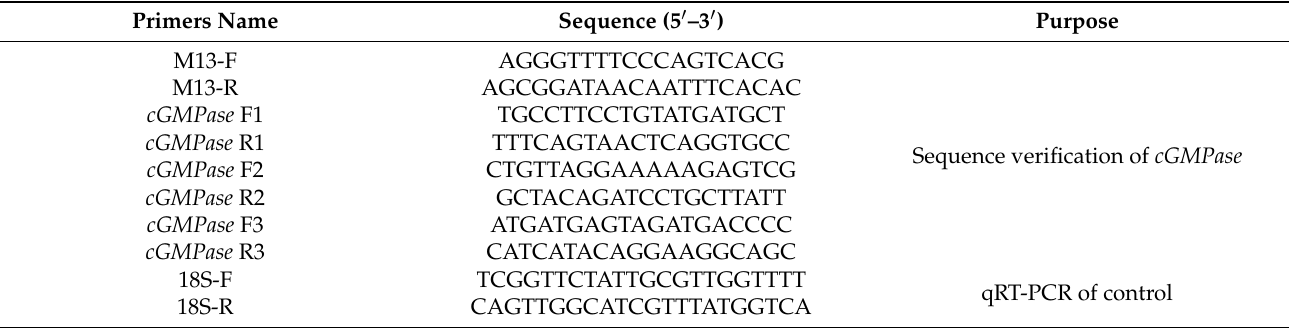
(Table 1) and the bacterial solution as template. The bacterial solution with the expected band size was selected and sent to Sangon Biotech (Shanghai, China) for sequencing. After removing the vector sequence, the sequencing results were compared with the original sequence. Table 1. Primers used for sequence